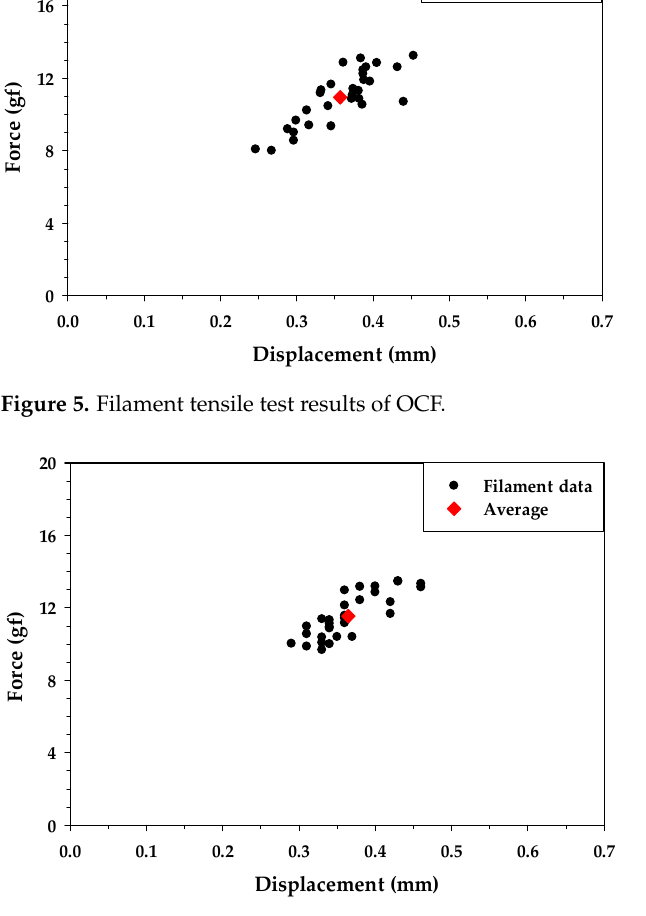
Figure 6. Filament tensile test results of RCF.